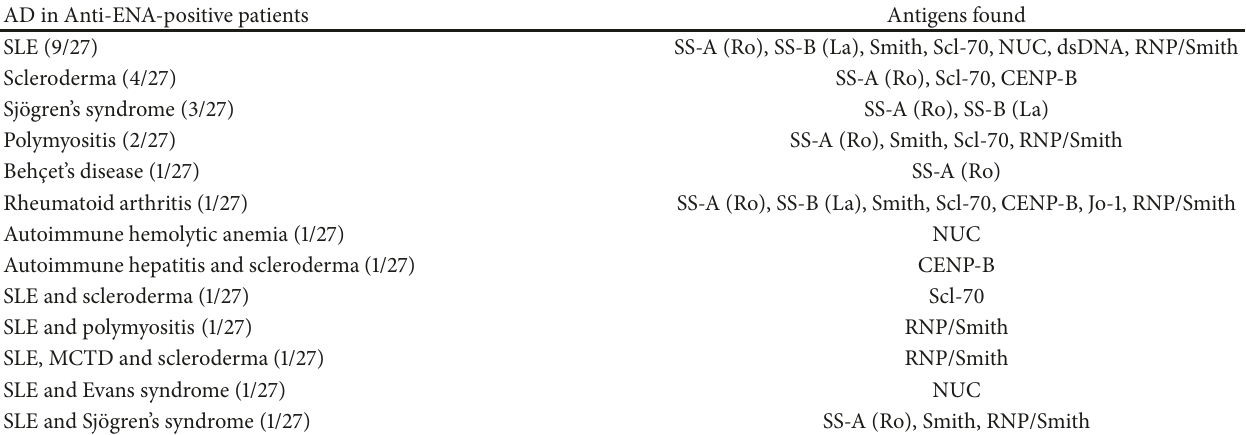
Table 3: Distribution of autoimmune diseases and autoantibodies against extractable nuclear antigens (anti-ENA). AD in Anti-ENA-positive